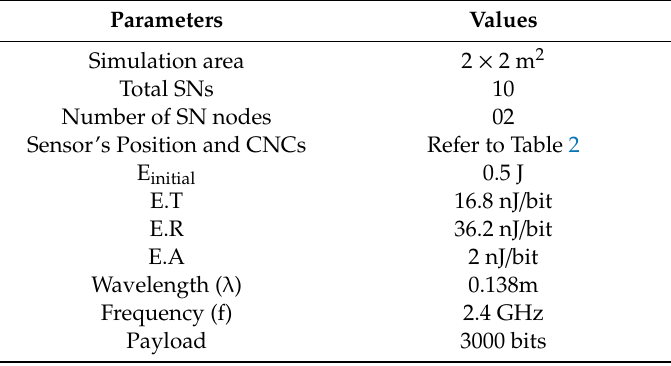
Table 3. EHCRP simulation constraints.